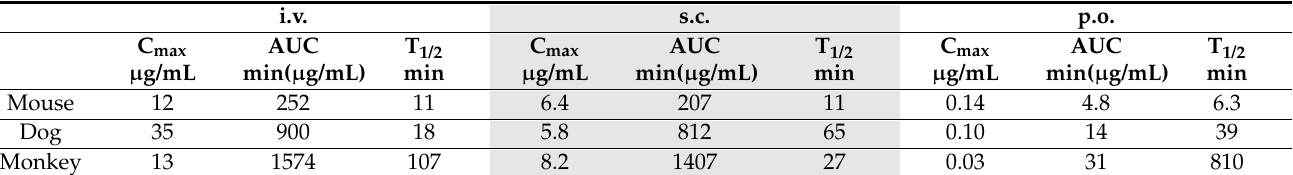
Table 2. Pharmacokinetic parameters for AFPep in mouse, dog, and primate models. i.v. s.c. p.o.